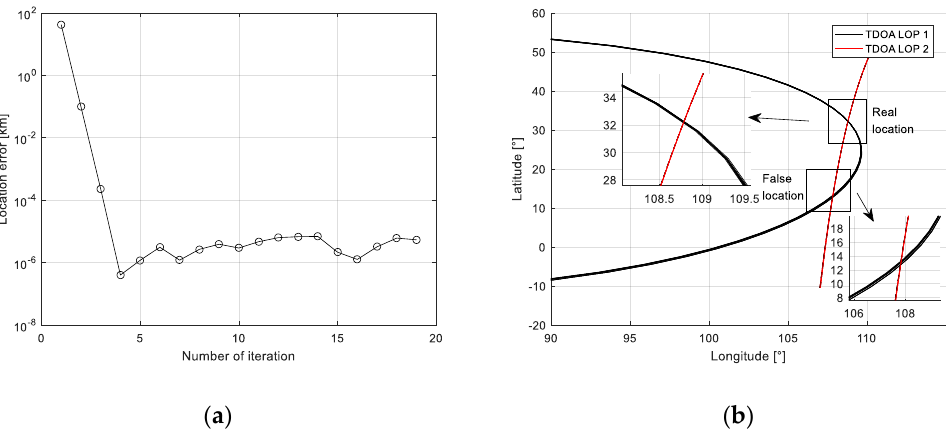
Figure 8. Results of the localization using the real data in actual test. ( a ) The location error versus the number of iterations; ( b ) description of what is contained in the second panel. Figures should be placed in the main text close to the first time they are cited. A caption on a single line should be centered. Table 1. Location results and location errors of the multiple time method and the proposed method.